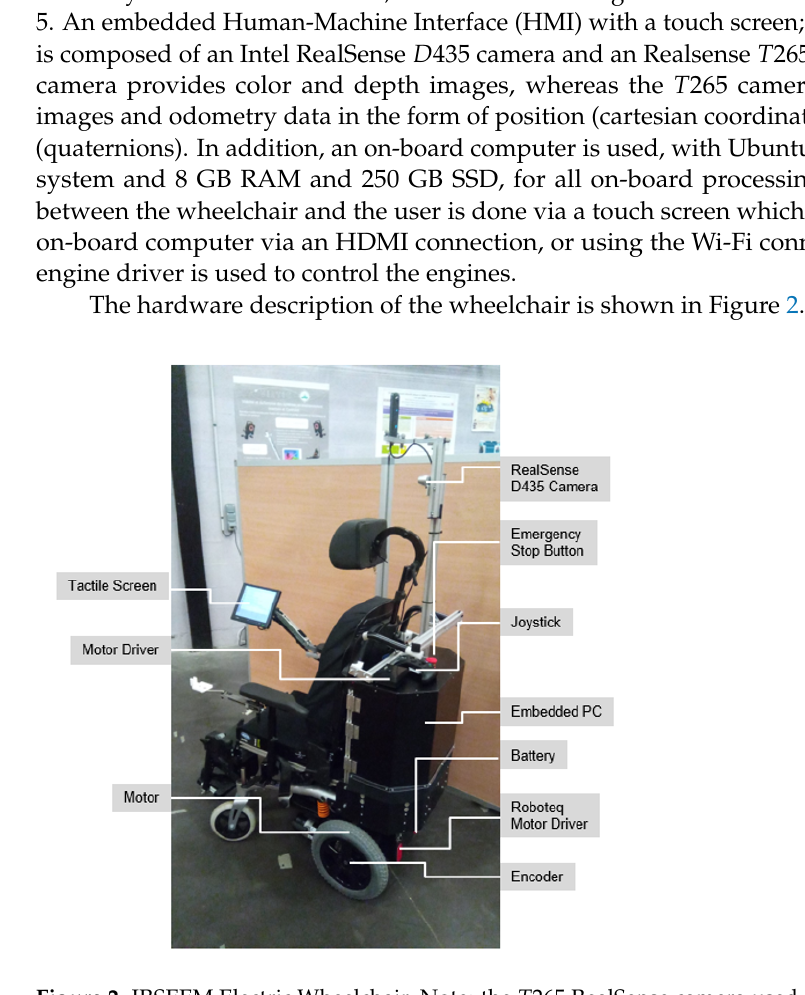
Figure 2. IRSEEM Electric Wheelchair. Note: the T 265 RealSense camera used for odometry was not mounted for this photo. For the experiments described in the text, it was placed near the D 435